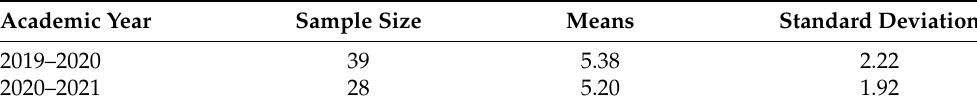
Table 14. Number of questions per subject in the final examination in both academic years.